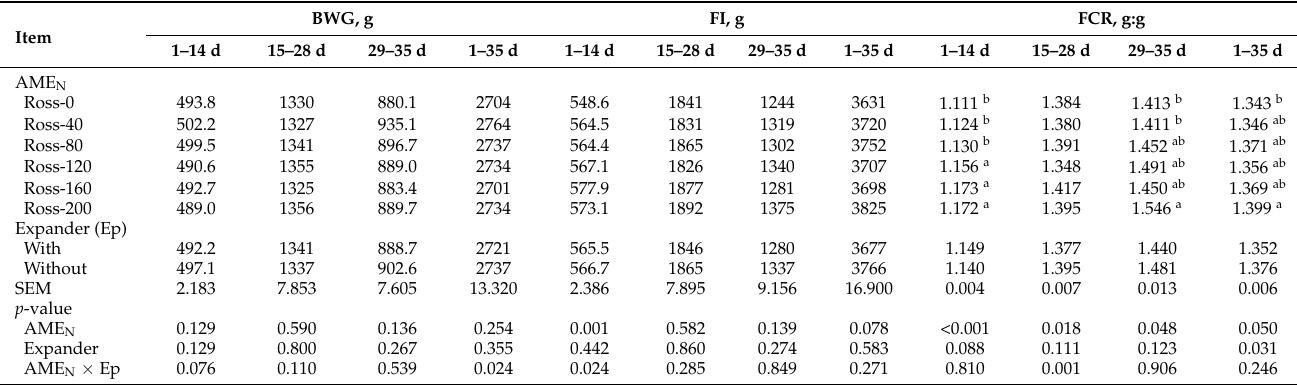
Table 9. Broiler performance from 1 to 35 days.